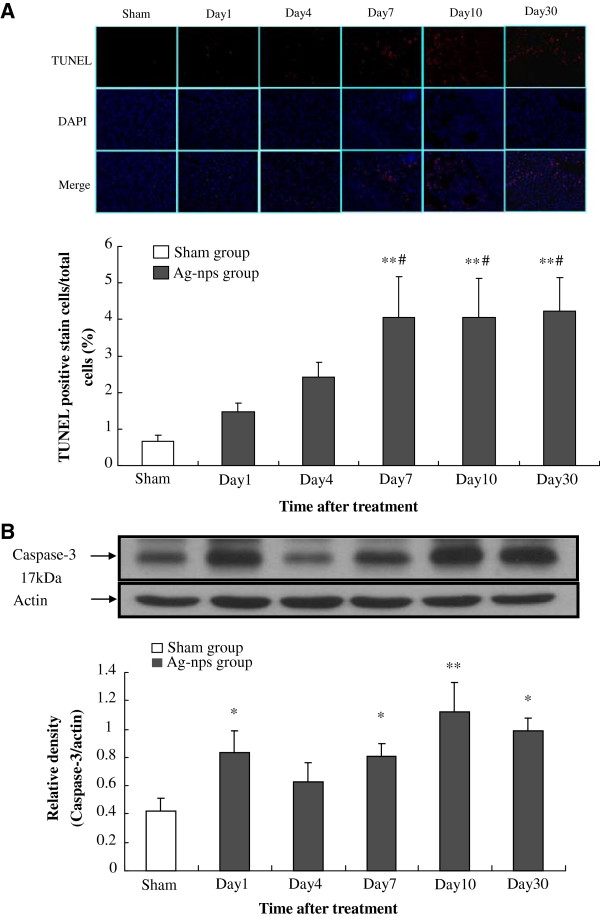
Level of the apoptosis was observed in hepatocytes. A: Fluorescence images of TUNEL staining (red) and DAPI staining (blue) in liver tissues at various time points following Ag-nps administration. Experiments were carried out as described under Materials and Methods. Upper panel shows representative histograms of TUNEL and DAPI staining while lower panel depicts quantitative analysis of TUNEL/DAPI positive cells. Values (means ± SD) presented in lower panel were obtained by dividing numbers of TUNEL positive cells with total numbers of cells from DAPI stain. Number of experiments was 6 for each time point. **p < 0.01 vs. sham group; #p < 0.05 vs. Day 1 group. B: Changes in caspase-3 protein expression in rat liver at various time points following Ag-nps administration. The experiments were performed as described under Material and Methods. Upper panel shows the representative immunoblots of caspase-3 while lower panel depicts densitometric analysis of immunoblots. Values were presented as means ± SD (n = 6). *p < 0.05 and **p < 0.01 compared to sham group.